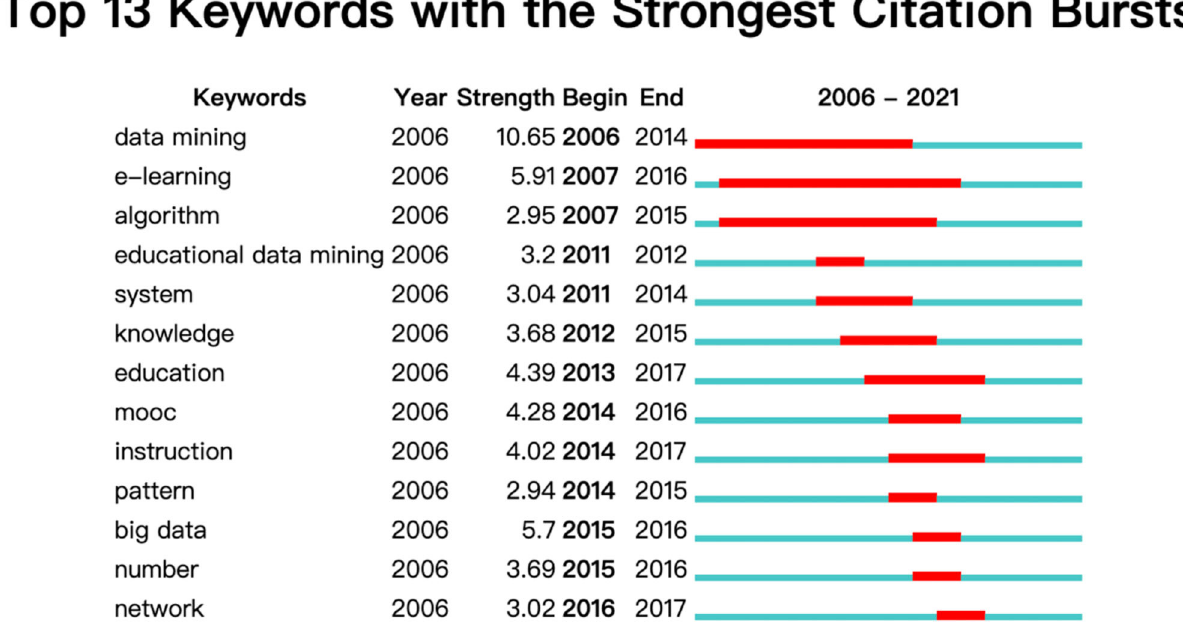
Chun” and “Hwang, Gwo Jen” were grouped in the cluster 2 and highlighted in